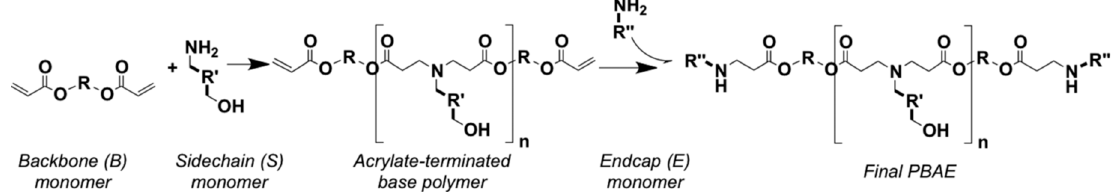
Figure 5. PBAE synthesis reaction scheme. Adapted with permission from Reference [129].